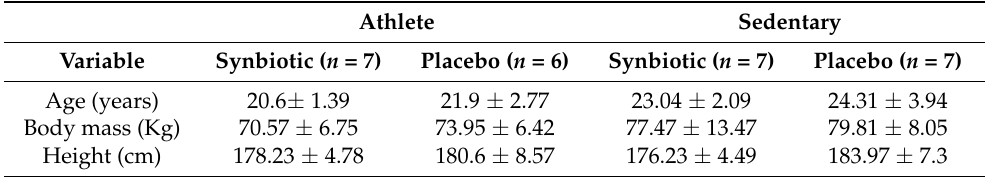
Table 1. Descriptive data of the